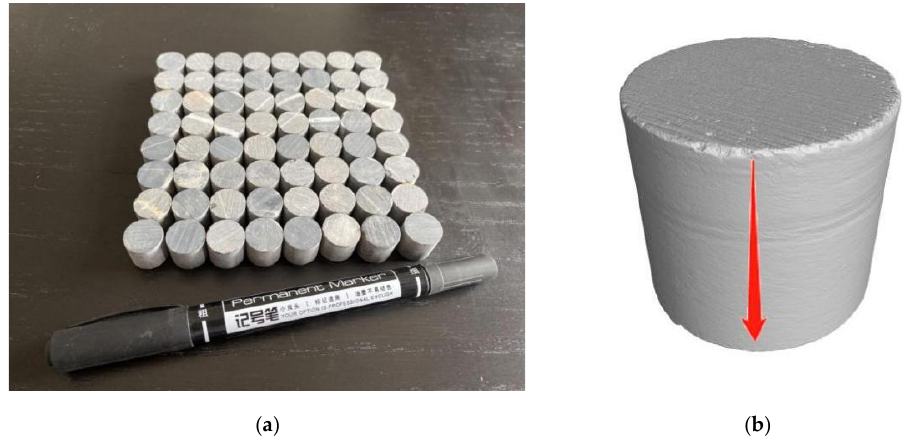
Figure 2. Picture of rock samples: ( a ) rock specimens; ( b ) location map of the rock sample.